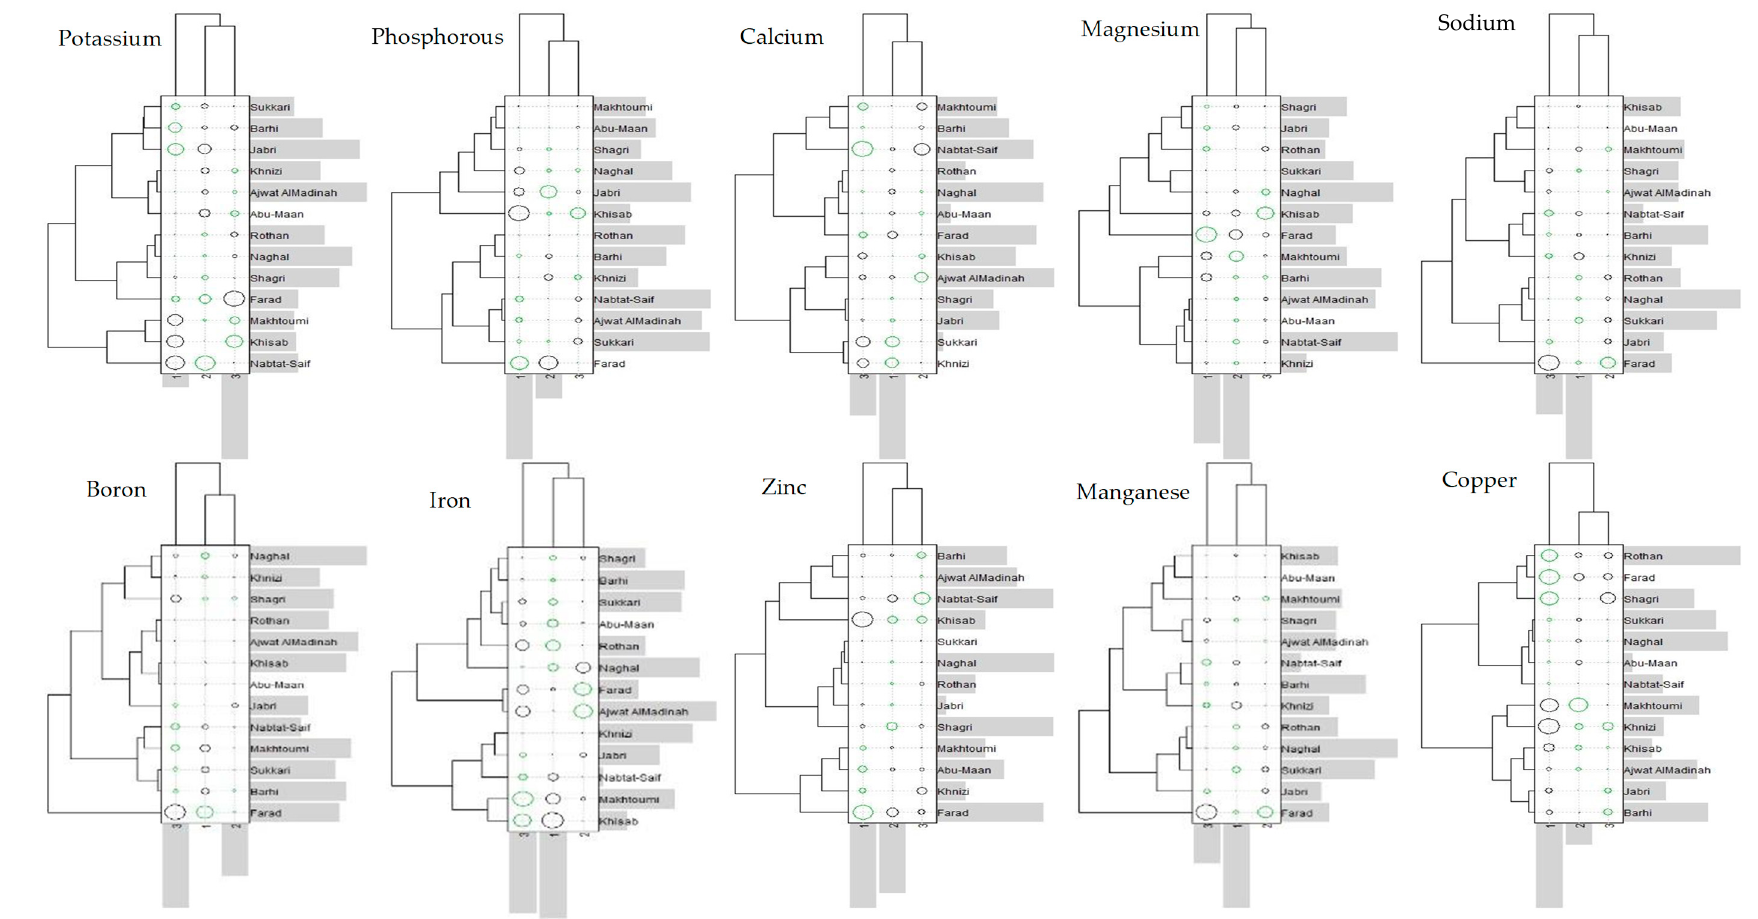
Figure 1. Genotype x Environment (Salinity) Interaction (GEI) Matrix of the fruit mineral content expression of 13 date palm varieties grown using three irrigation water salinity levels corresponding to electrical conductivities of 5, 10 and 15 dS m − 1 denoted as 1, 2, and 3,